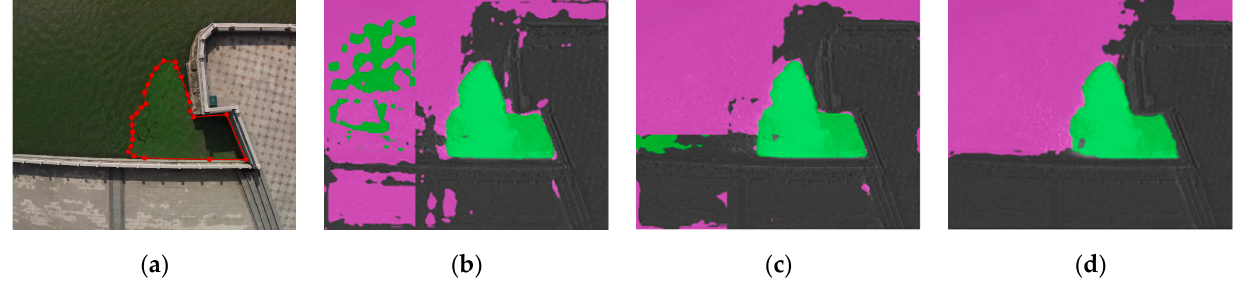
Figure 7. Detection results of different deep-learning algorithms for regular scene: ( a ) visible light images; ( b ) detection results of FCN; ( c ) detection results of SegNet; ( d ) detection results of improved transformer model.